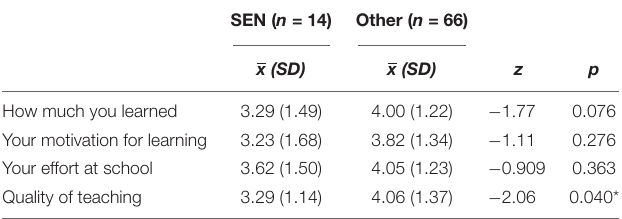
TABLE 2 | Students’ ratings of the quality of their education during school closings and results of between-group comparisons. SEN ( n = 14) Other ( n =